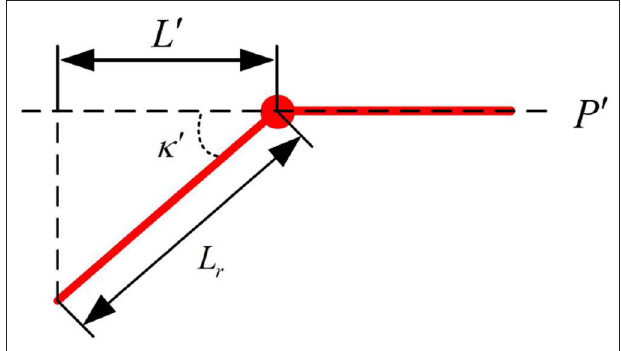
FIGURE 5 | Aerial view of nonobjective human.